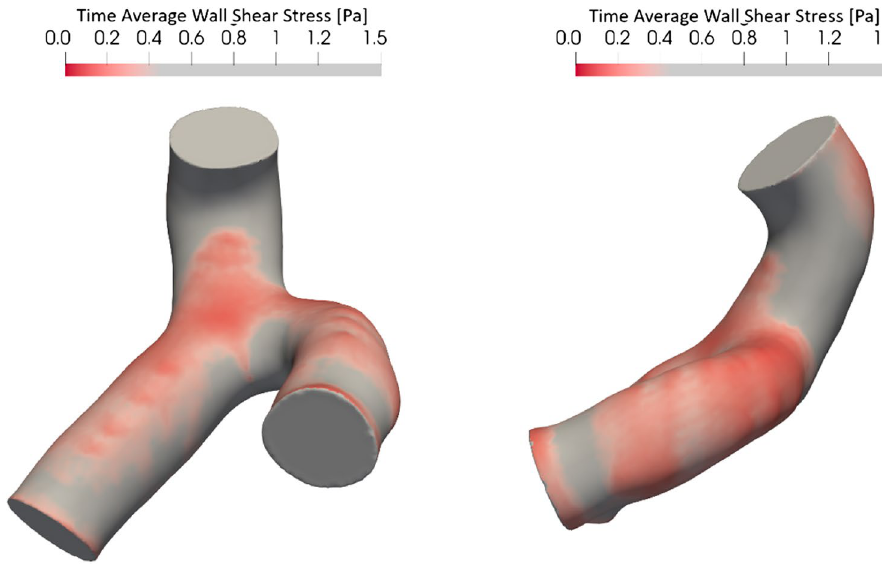
Figure 5. Example of low Time Average Wall Shear Stress (TAWSS)